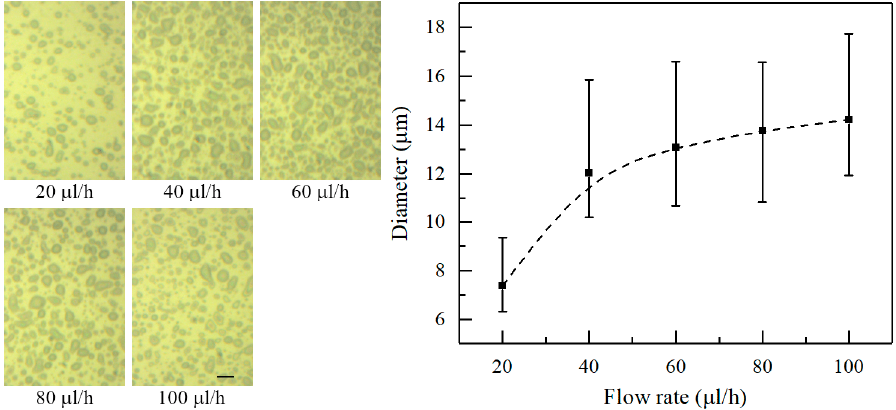
Figure 6. Effect of the flow rate on the diameter of electrosprayed particles. The nozzle-to-substrate distance and the applied voltage are 10 mm and 2.5 kV, respectively. The optical photographs inset are the electrosprayed particles. Scale bar: 20 μ m.